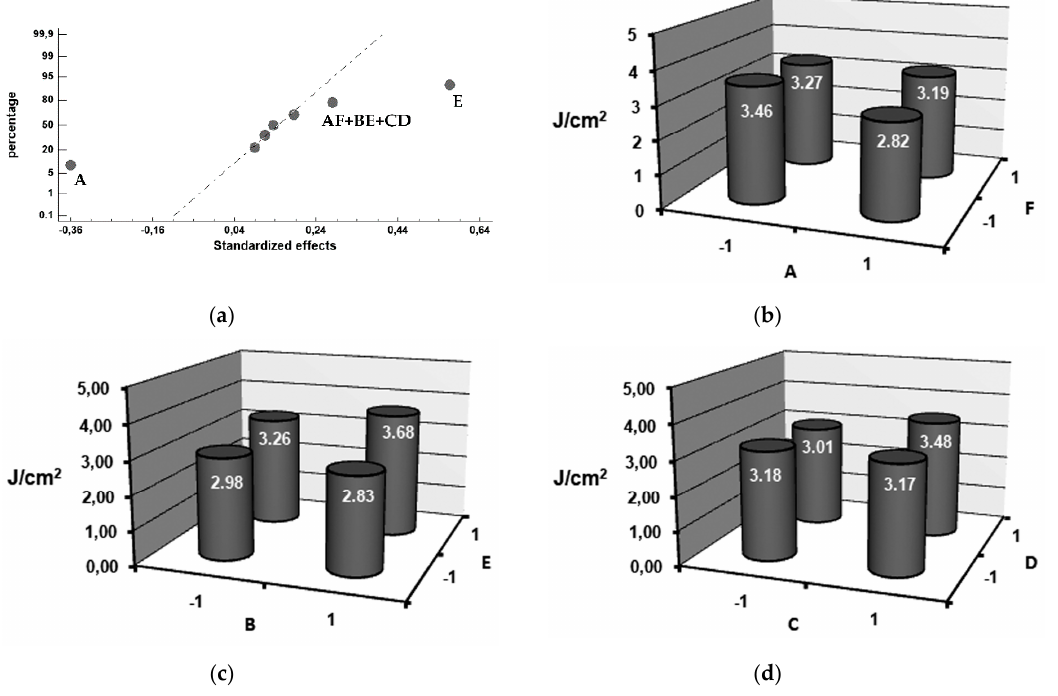
Figure 2. Factors that have a significant effect on impact toughness in the bond interface. ( a ) Standardized effects on a normal probability plot, ( b ) Analysis of interaction AF, ( c ) Analysis of interaction BE, ( d ) Analysis of interaction CD.